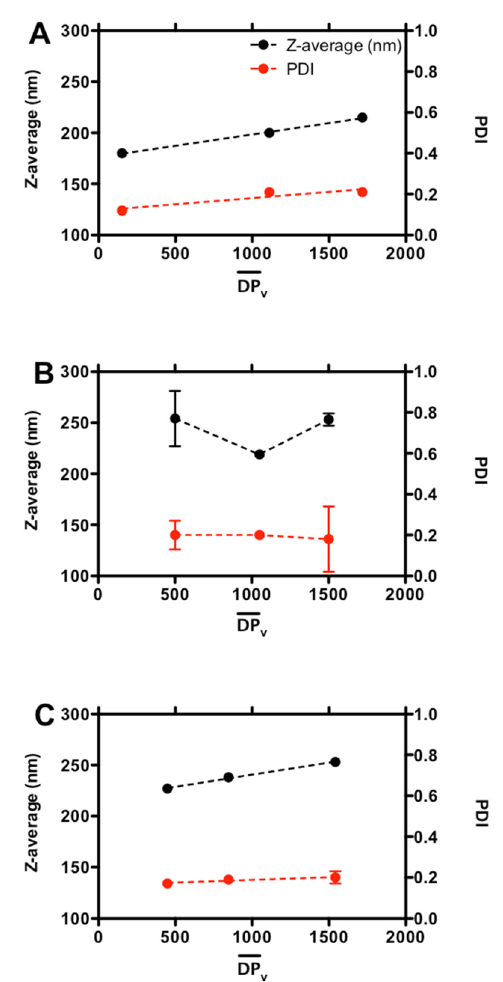
Figure 1. The dependence of the coacervate hydrodynamic diameter (Z-average) and polydispersity index (PDI) on the chitosan degree of polymerization ( DP v ), for formulations at different fractions of acetylated units, F A : F A = 0.16 ( A ), F A = 0.46 ( B ) and F A = 0.63 ( C ). Dashed lines are drawn to guide the eye.